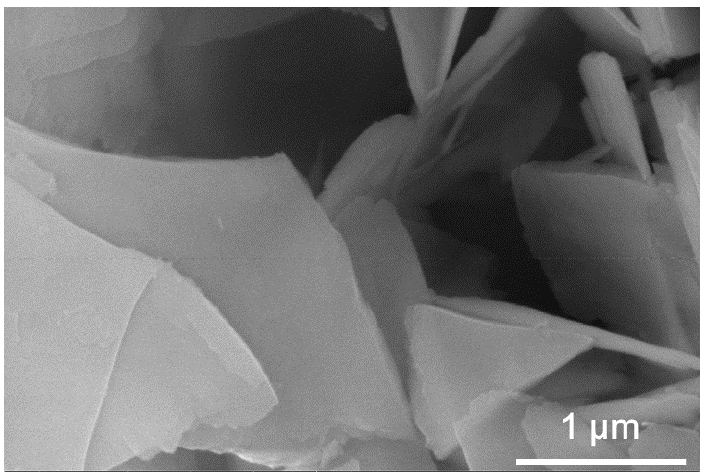
Figure 1. Scanning electron microscopy images for as-prepared ZnO NS before